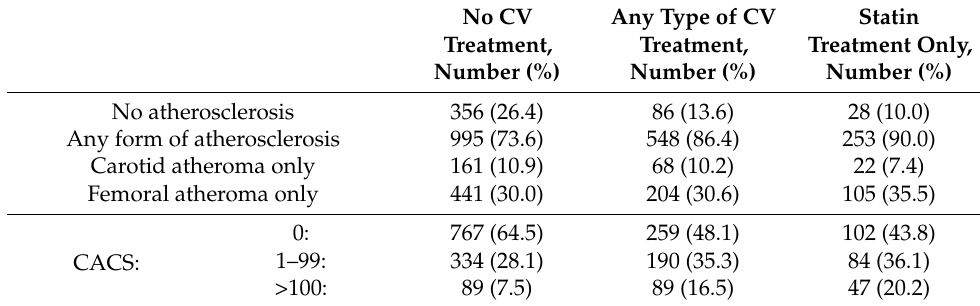
Table 4. Pharmacological treatment and presence of subclinical